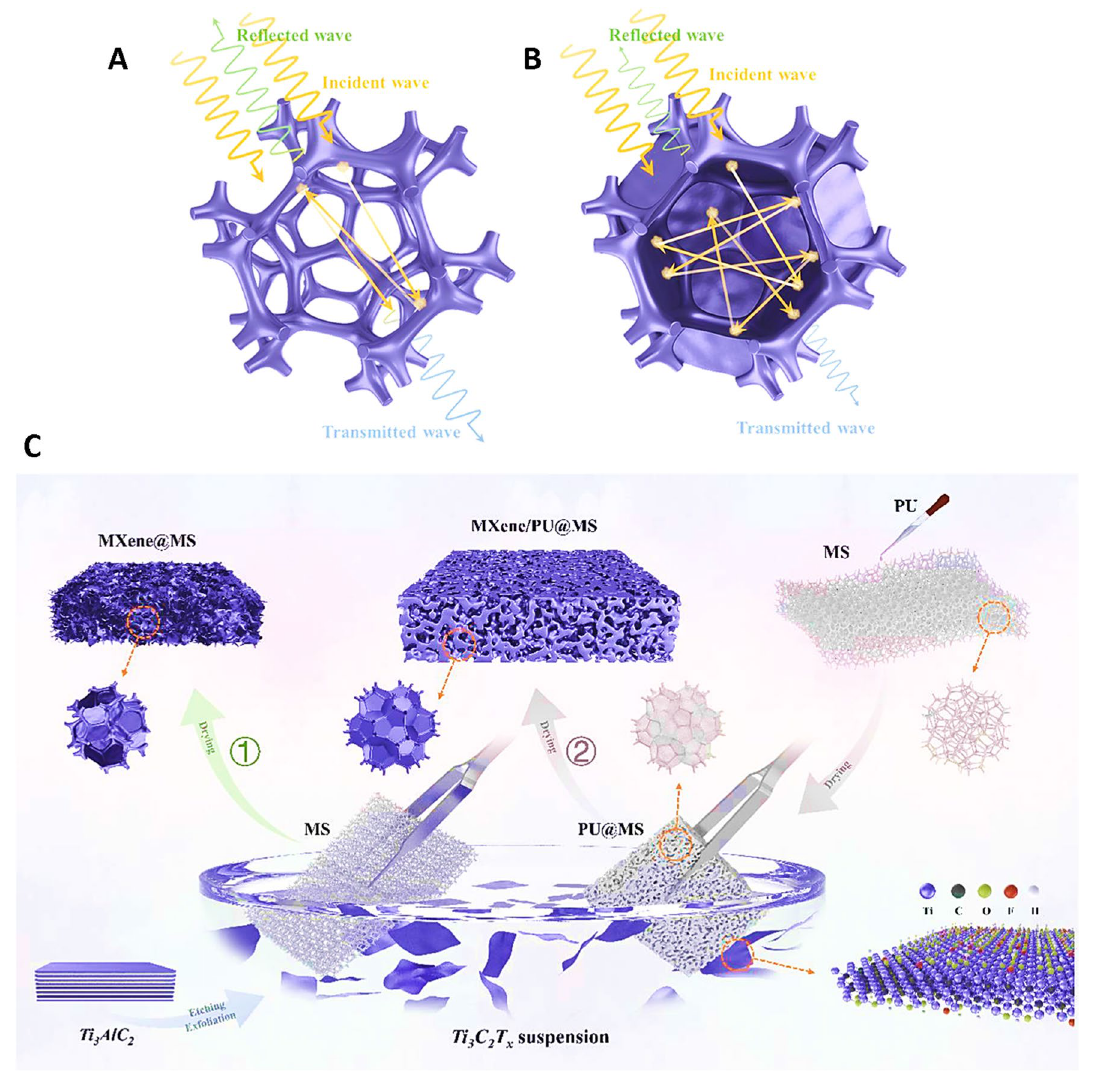
Fig. 5 Three-dimensional (3D) porous composite sponges with skeletons wrapped by functional filler ( A) , and pores covered by functional filler ( B) , with related propagation route of electromagnetic waves. C The preparative process of ( 1) self-healing MXene-wrapped melamine sponge (MS) and ( 2) MXene/polyurethane (PU)@MS. Reproduced with permission from Ref. [71]. Copyright 2021